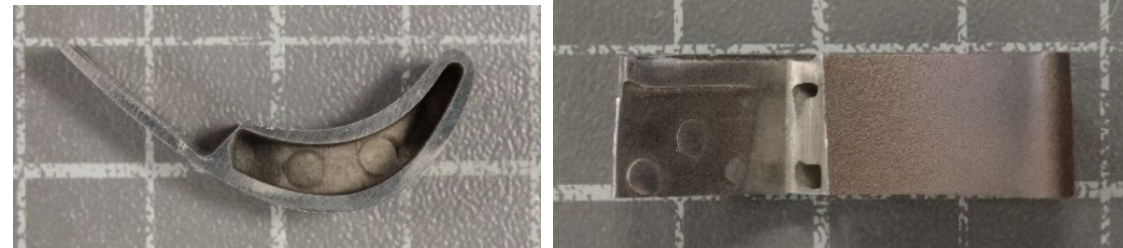
Figure 3. A fragment of a blade with a sample cut out for testing the diffusivity of a protective coating.